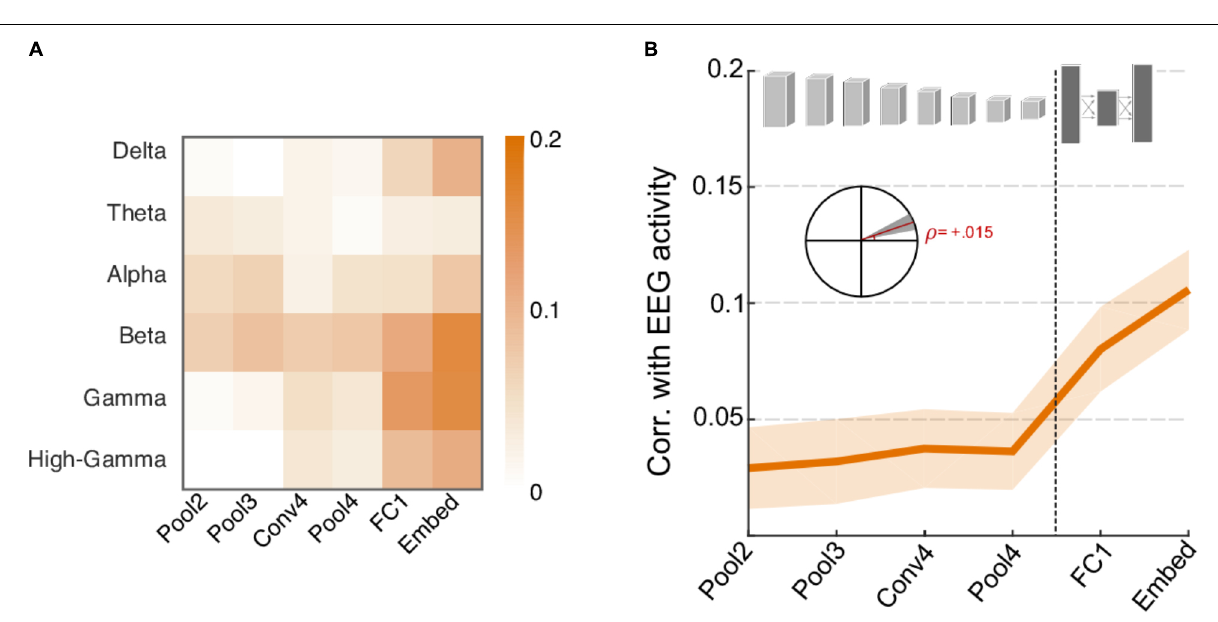
FIGURE 7 | Correlation between neural network activity and energy in EEG frequency bands. (A) Correlation coefficients between individual EEG frequency bands and layers of the neural network. Gamma, Beta, and High-Gamma frequency bands are the most strongly correlated bands overall. (B) Average correlation across EEG activity and layers of the neural network. Shaded area depicts ± 1 SEM. Inset shows the slope of the trend line fitted with linear regression, with a shaded area depicting the 99% confidence interval of the